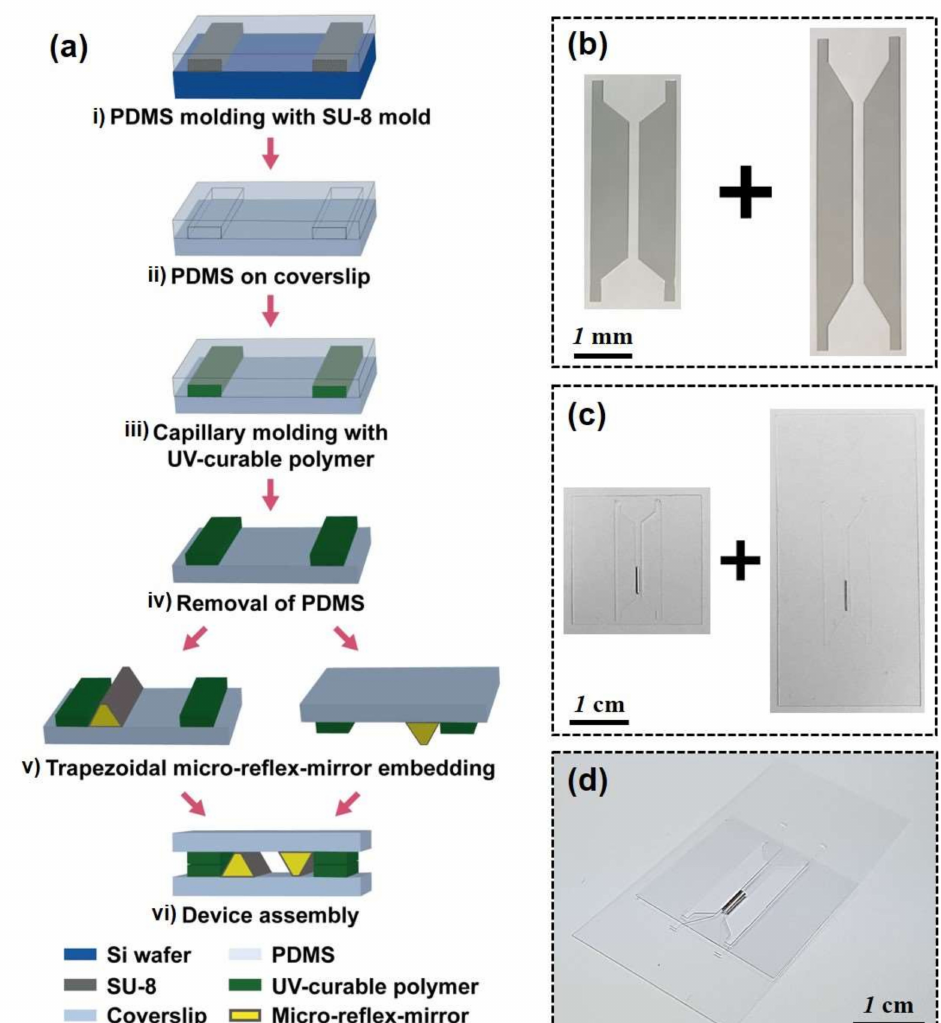
Figure 3. A fabrication process for micromirror-embedded coverslip assembly. ( a ) Fabrication steps for coverslip assembly. ( b ) SU-8 mold for parallel column structures ( c ) Coverslips with the embedded micromirrors ( d ) Final assembled coverslip